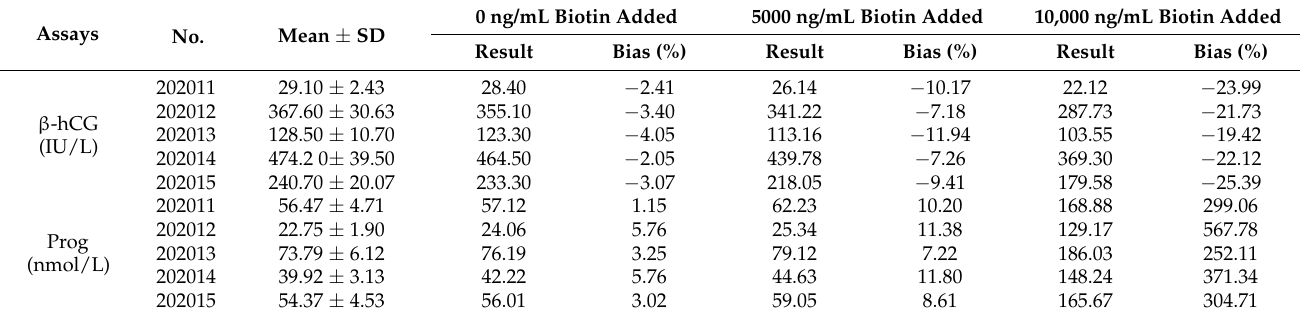
Table 3. Bias of EQA samples at different biotin concentrations.